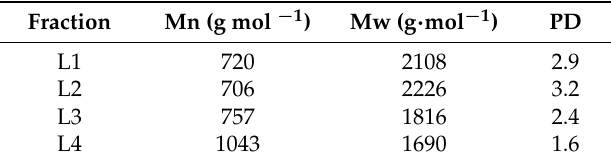
Figure 7. Size exclusion chromatography (SEC) analysis of kraft lignin purification fractions: L1 (blue), L2 (red), L3 (green), and L4 (purple). Number average molecular weight (Mn), weight average molecular weight (MW), and polydispersity (PD) of lignin fractions L1 to L4 obtained from the size exclusion chromatography (SEC)